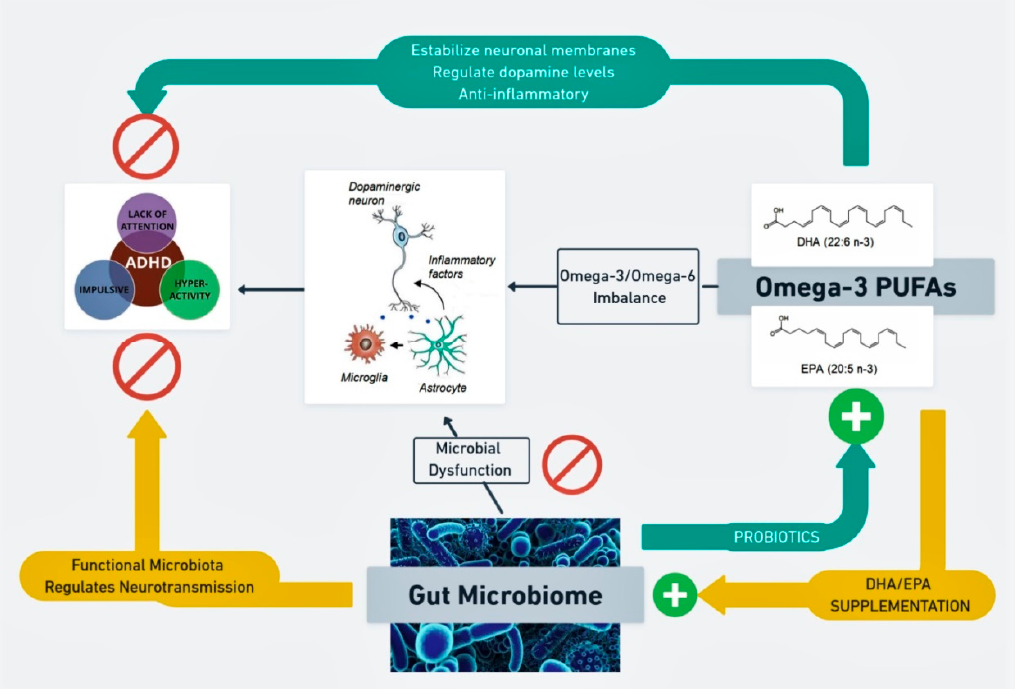
Figure 3. Interaction between the gut microbiome and omega-3 PUFAs (polyunsaturated fatty acids), and effect on ADHD symptoms. The imbalance in the omega-3:omega-6 PUFA ratio leads to a state of neuroinflammation and a consequent disruption in the dopaminergic system (black arrows). Dopaminergic dysfunction is one of the main factors contributting to ADHD core symptoms. Alterations in the microbial composition have also been associated with ADHD symptoms, apparently via the influence of the gut microbiome on neurotransmission (microbiome–gut–brain axis (MGBA)). The administration of probiotics (green arrow) may boost the concentrations of omega-3 PUFAs. This would correct the omega-3:omega-6 imbalance and ultimately improve ADHD symptoms by stabilizing neuronal membranes, dopaminergic neurotransmission and reducing neuroinflammation. On the other hand, supplementation with eicosapentaenoic/docosahexanoic acids (EPA/DHA) (yellow arrow) could induce changes in the microbial composition that would be beneficial for ADHD symptoms, via dopaminergic neurotransmission regulation (MGBA).